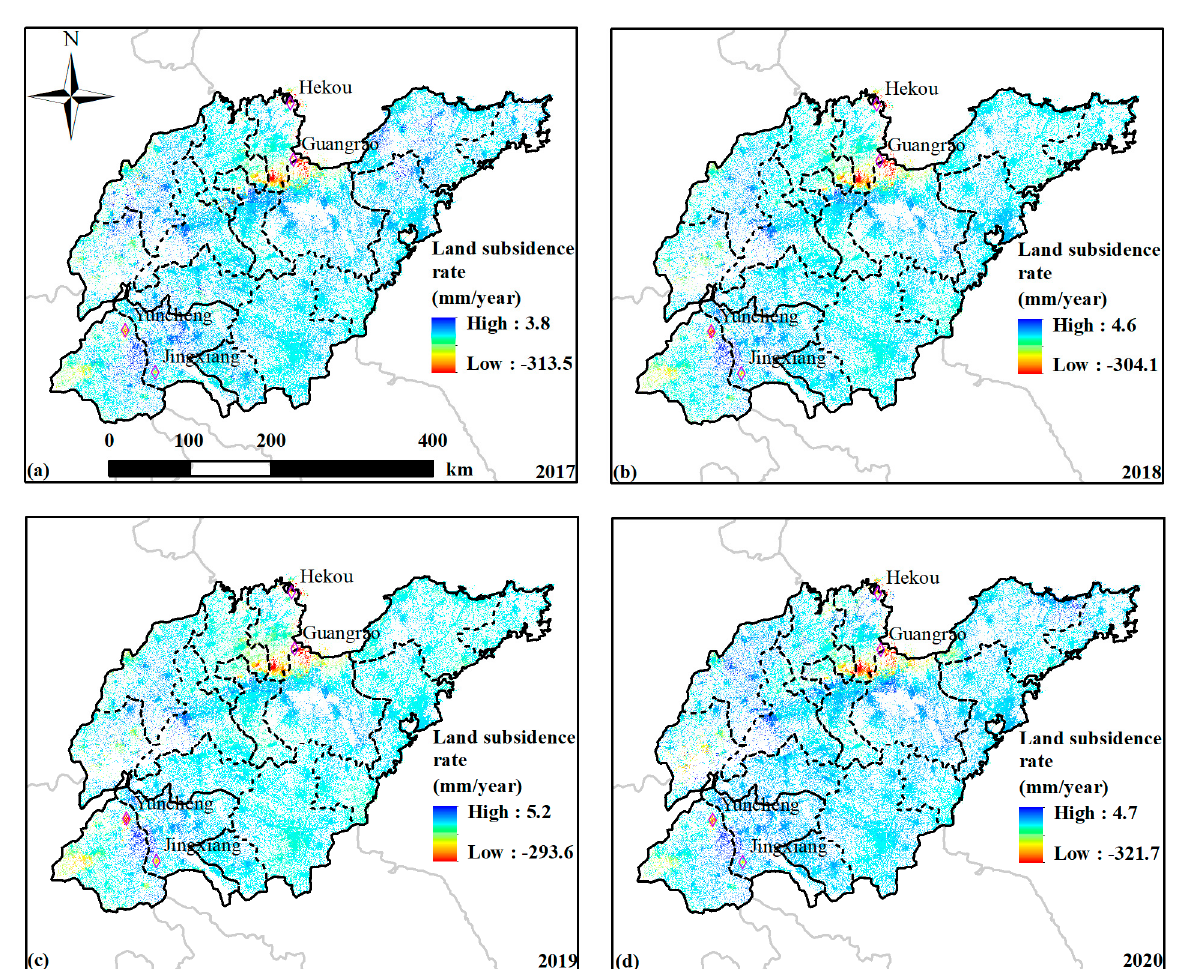
Figure 4. The annual land subsidence rates throughout Shandong Province (SDP) during the obser- vation period. ( a ) indicates the land subsidence in 2017, ( b ) indicates the land subsidence in 2018, ( c ) indicates the land subsidence in 2019, and ( d ) indicates the land subsidence in 2020.